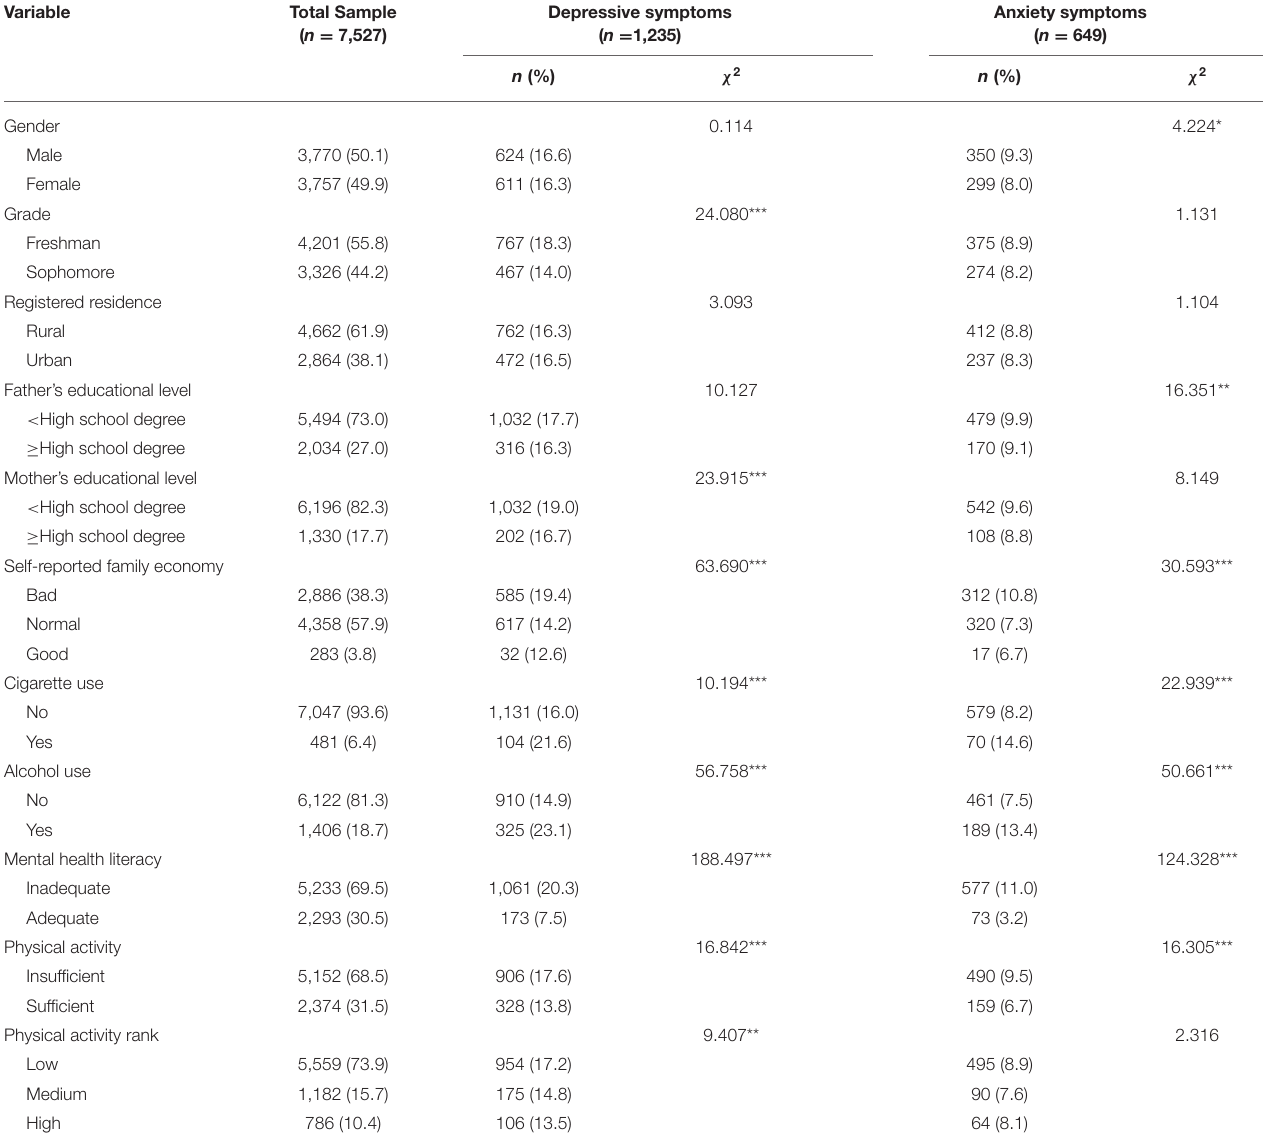
TABLE 1 | Prevalence of depressive symptoms and anxiety symptoms in college students.